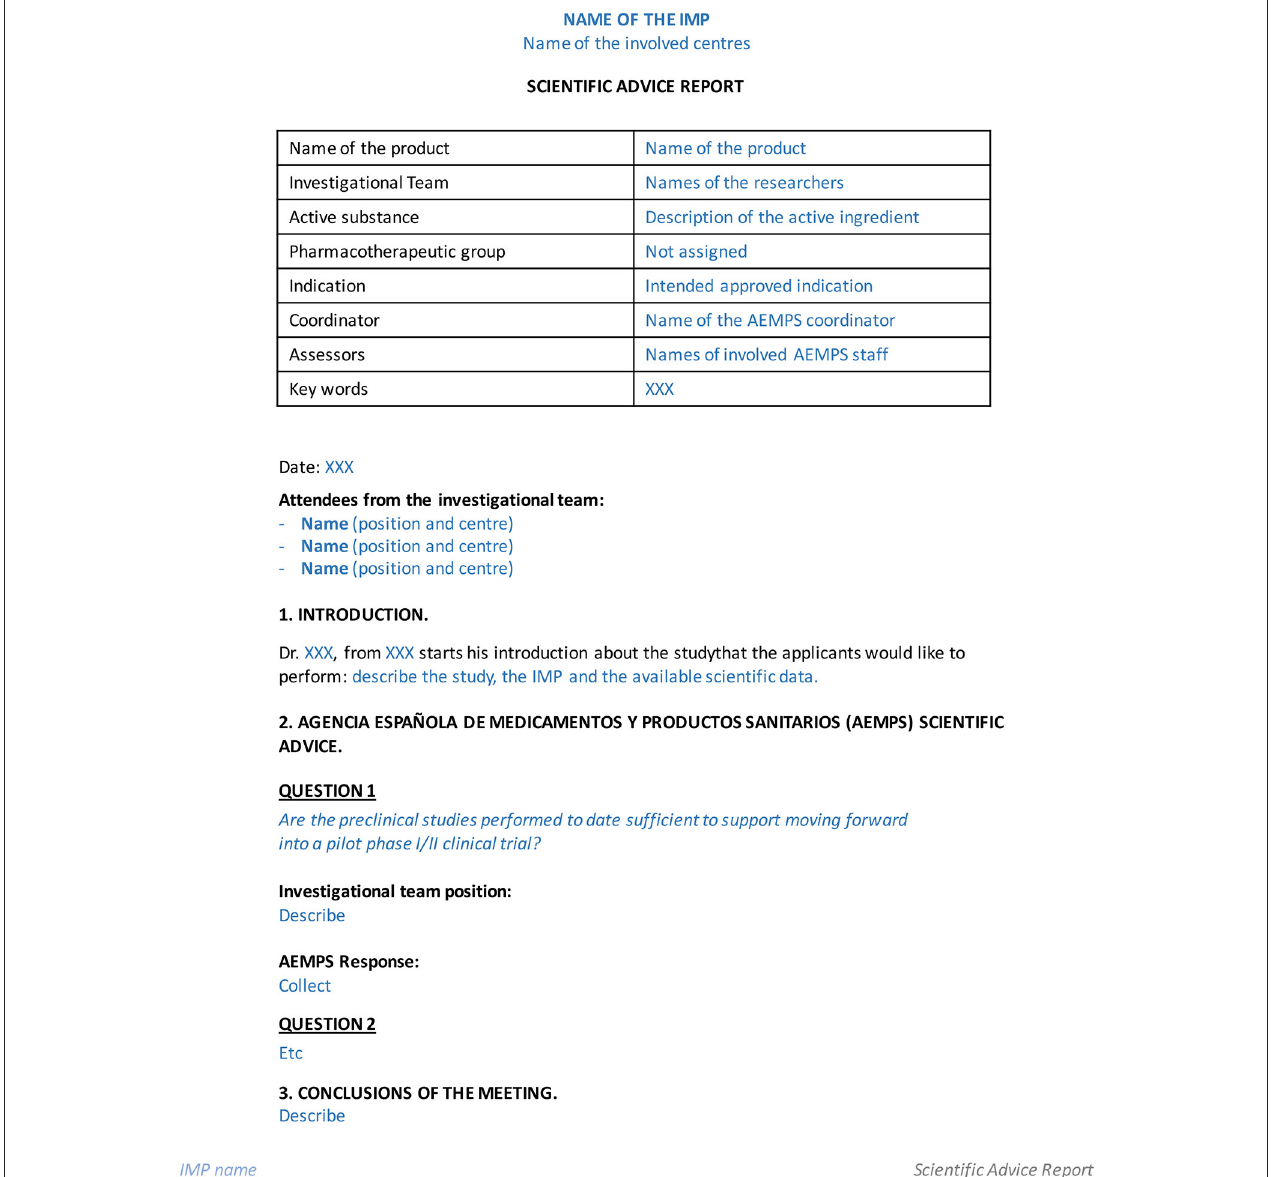
FIGURE 2 | Template to write minutes after obtaining scientific advice from the Spanish Agency of Medicines and Medical Devices